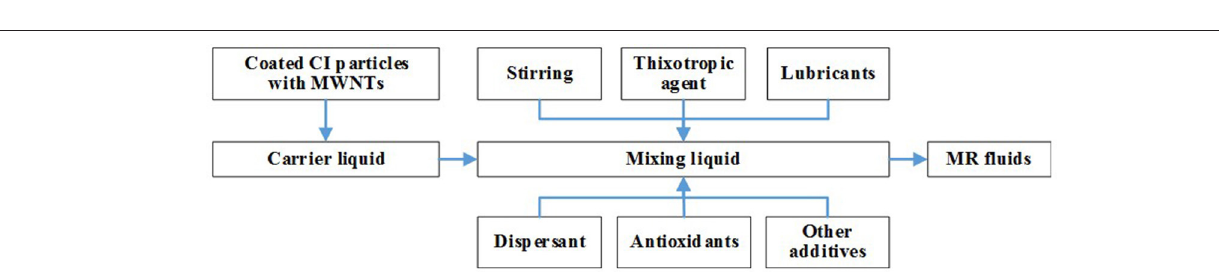
FIGURE 3 | Preparation process of MR fluids.